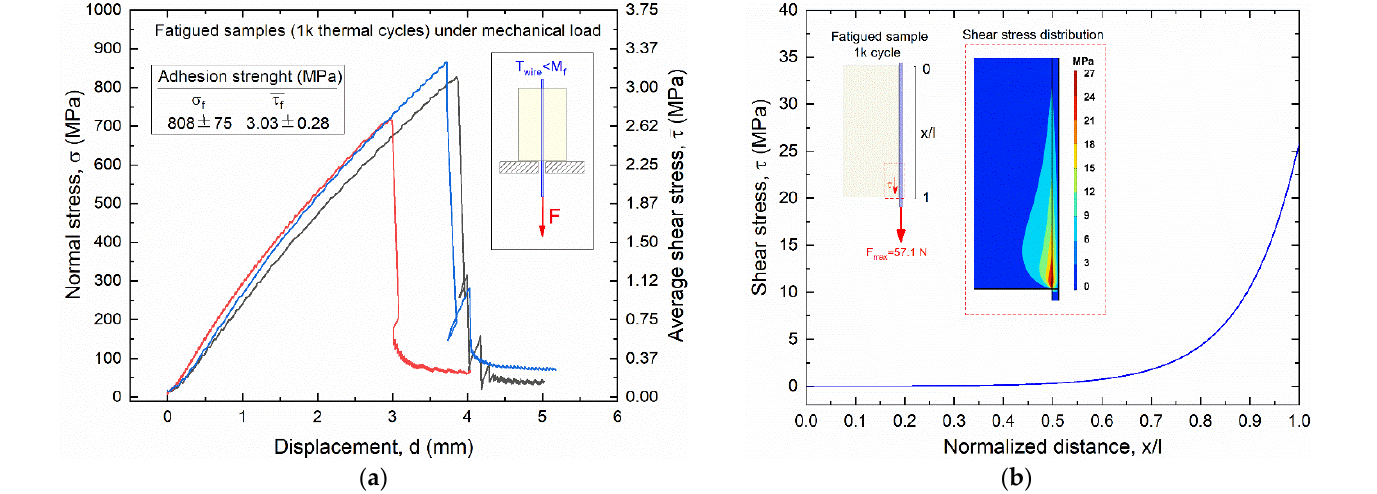
Figure 18. Stress vs. displacement curves obtained from pullout tests of SMA–polymer samples subjected to 1000 thermal activation cycles. Results of static pullout tests of samples subjected to 1000 thermal activation cycles: ( a ) experimental stress vs. displacement curves obtained from three different samples; ( b ) FE results of the shear stress distribution at the wire–resin interface along the contact length at the pullout force F max = 57.0